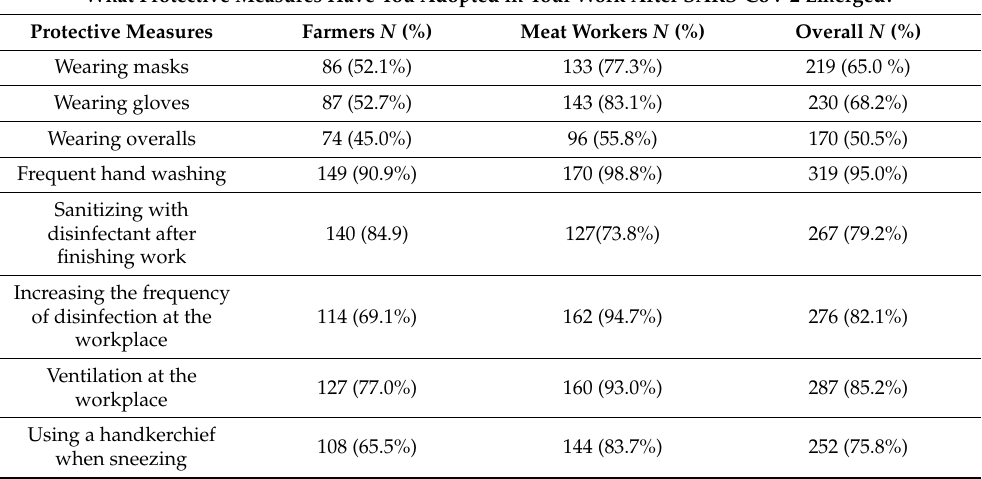
Table 3. The impact of SARS-CoV-2 on hygiene practices among farmers and meat workers in the chicken meat production